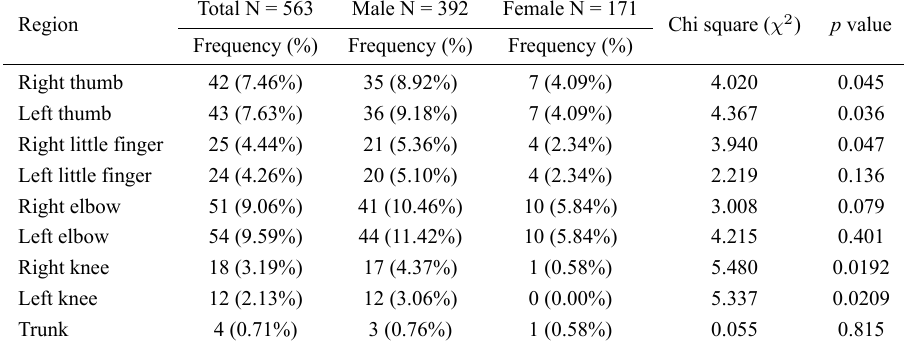
Table 4. Prevalence of joint hypermobility at various sites used in the Beighton criteria (Cut-off ≥ 4).